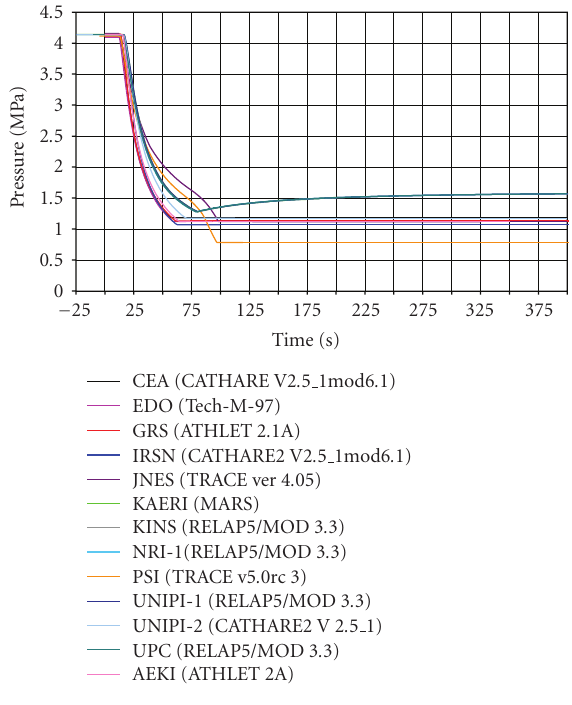
Figure 6: Time trends of accumulator 1 pressure.